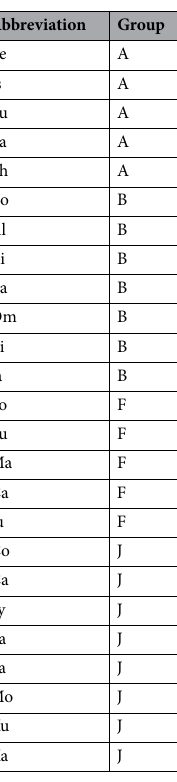
Table 4. Description of the individuals included into the